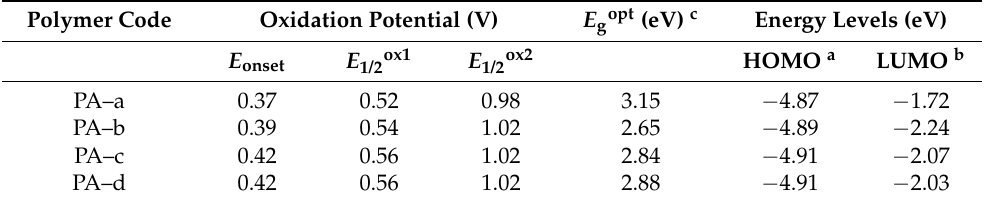
Table 3. Electrochemical properties of PAs.